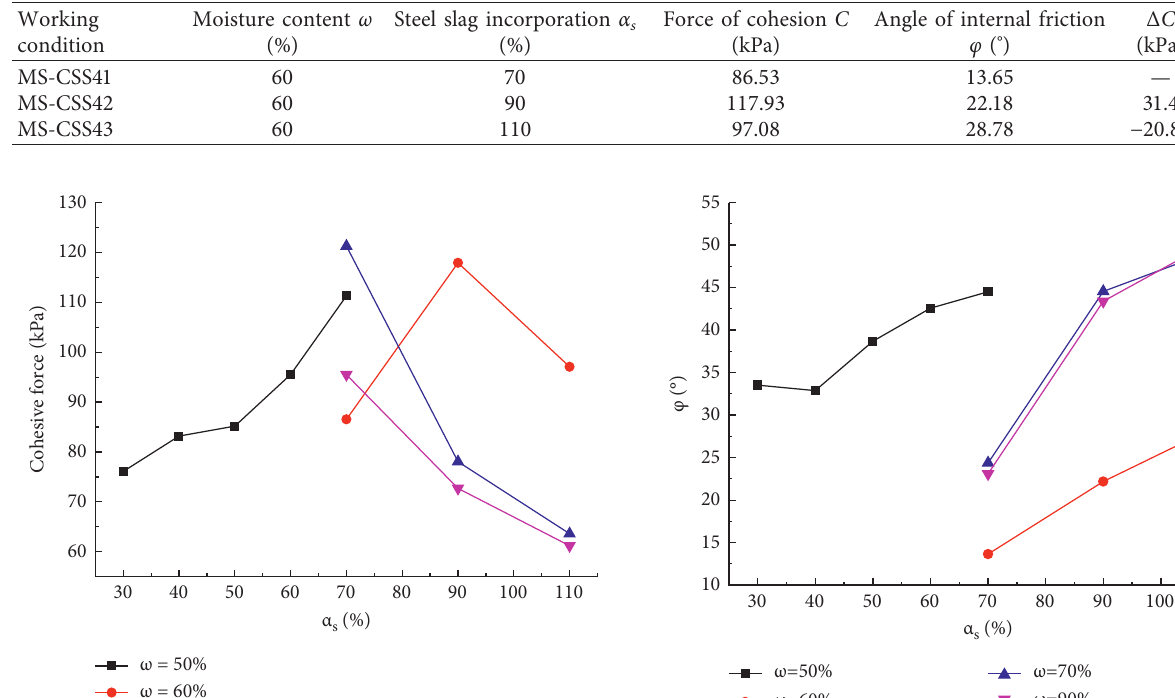
Table 7: Cohesion and internal friction angle of mixture soil with 60% moisture.